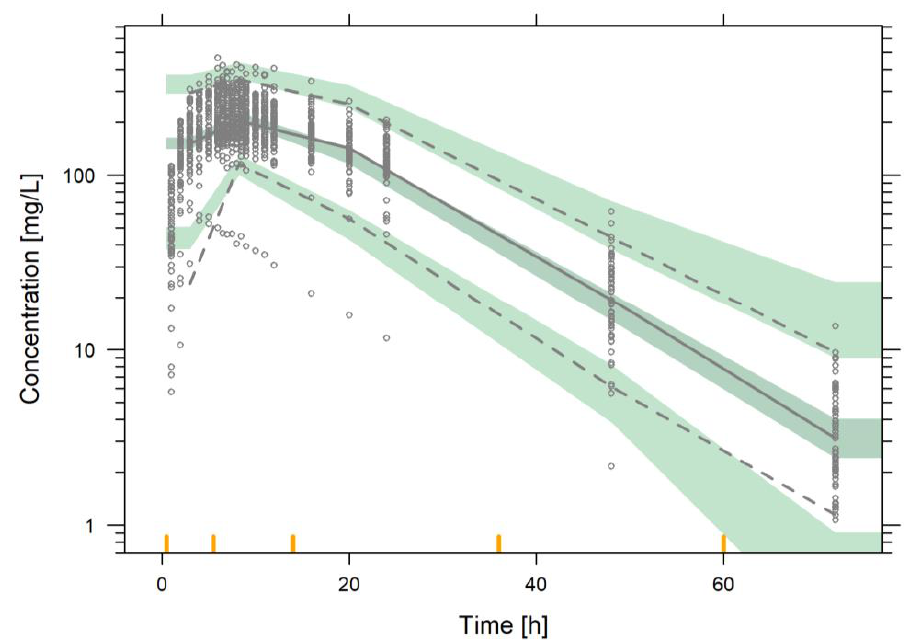
Figure 3. Visual Predictive check of the final population pharmacokinetic model for 100 mg of desvenlafaxine prolonged-release tablets after a single dose in healthy volunteers. Grey lines represent the 2.5th, 50th and 97.5th experimental percentiles. Grey shaded areas represent the 95% prediction interval of the 2.5th, 50th and 95th percentiles. Empty grey dots represent the experimental desvenlafaxine observations.